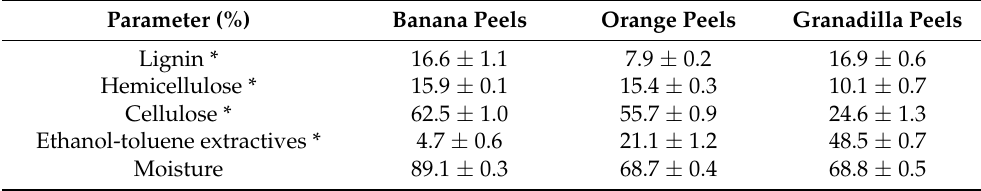
Table 1. Physical and chemical characteristics of banana, orange, and granadilla